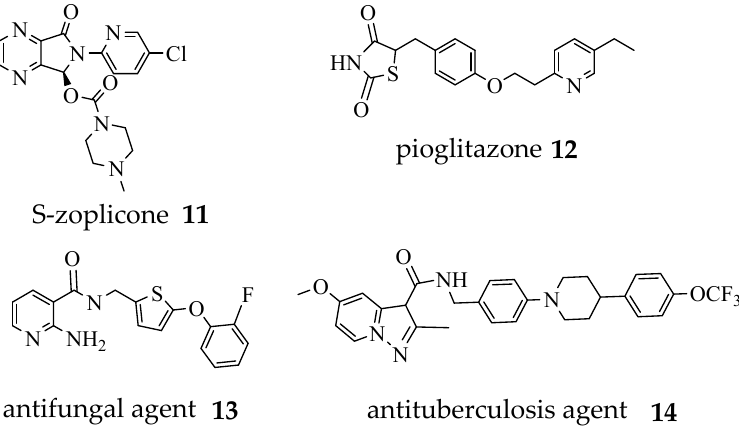
Figure 2. Some biologically active molecules containing pyridines.